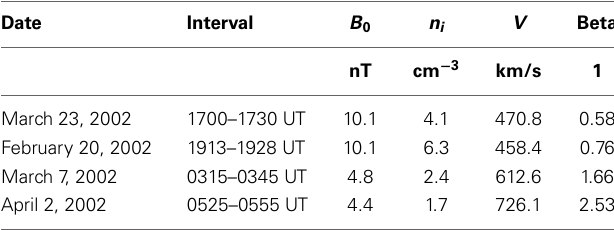
Table 1 | Interval parameters (magnetic field magnitude B 0 , the ion number density n i , the flow speed V , and the plasma parameter beta for